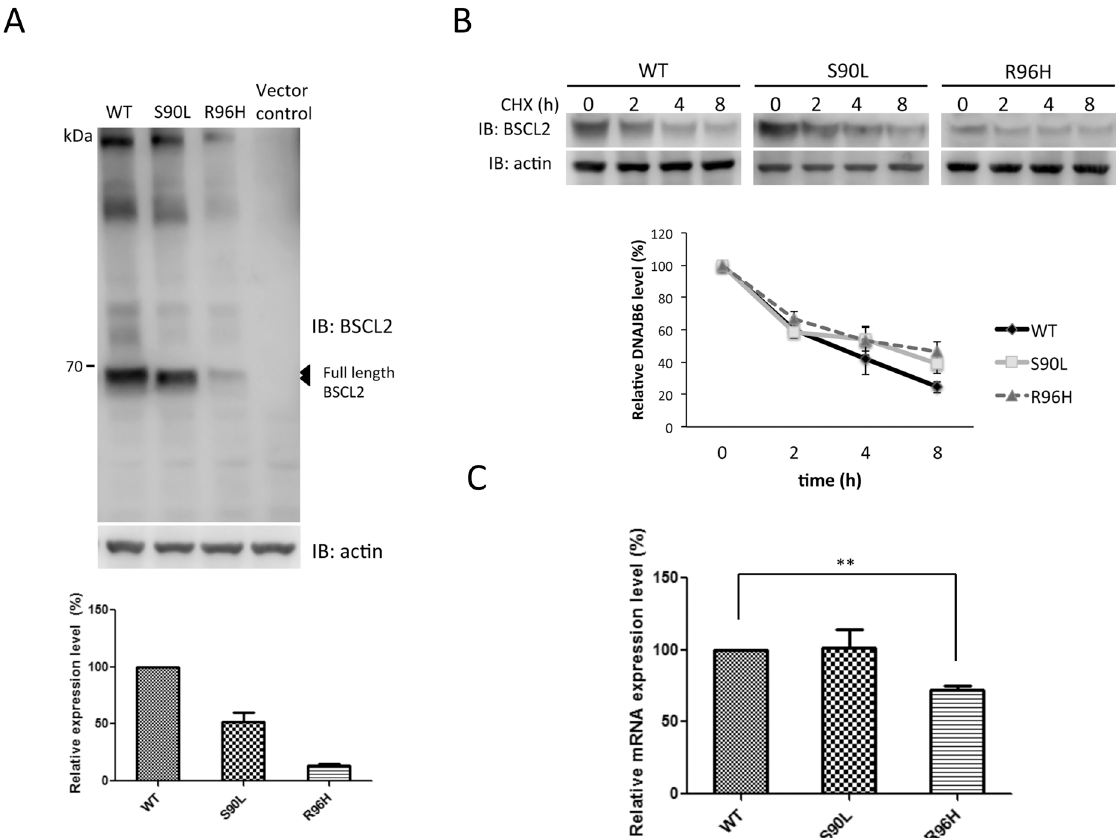
Fig 2. In vitro expression of BSCL2 in HEK293 cells. (A) Representative western blot analysis of seipin in the HEK293 cells transfected with plasmids expressing wild-type (WT), S90L, or R96H seipin, or empty vector (vector control). Actin was used as a loading control. Densitometric quantification is shown below. The error bars indicate standard error of the mean (SEM) from 3 independent experiments. IB, immunoblotting. (B) HEK293 cells were transfected with expression plasmids for the WT, S90L, or R96H seipin for 48 hours and subsequently subjected to cycloheximide-chase assays. Representative western blots is shown above. All values are shown as means ± SEM (n = 4). (C) The messenger RNA (mRNA) levels of BSCL2 in the HEK293 cells transfected with WT, S90L, or R96H seipin expression plasmids for 24 hours. The expression levels of BSCL2 were normalized to those of GAPDH and expressed as a fraction of the WT samples, which was set as 100%. The error bars indicate SEM (n = 3). The asterisk indicates statistically significant difference ( ** , p <